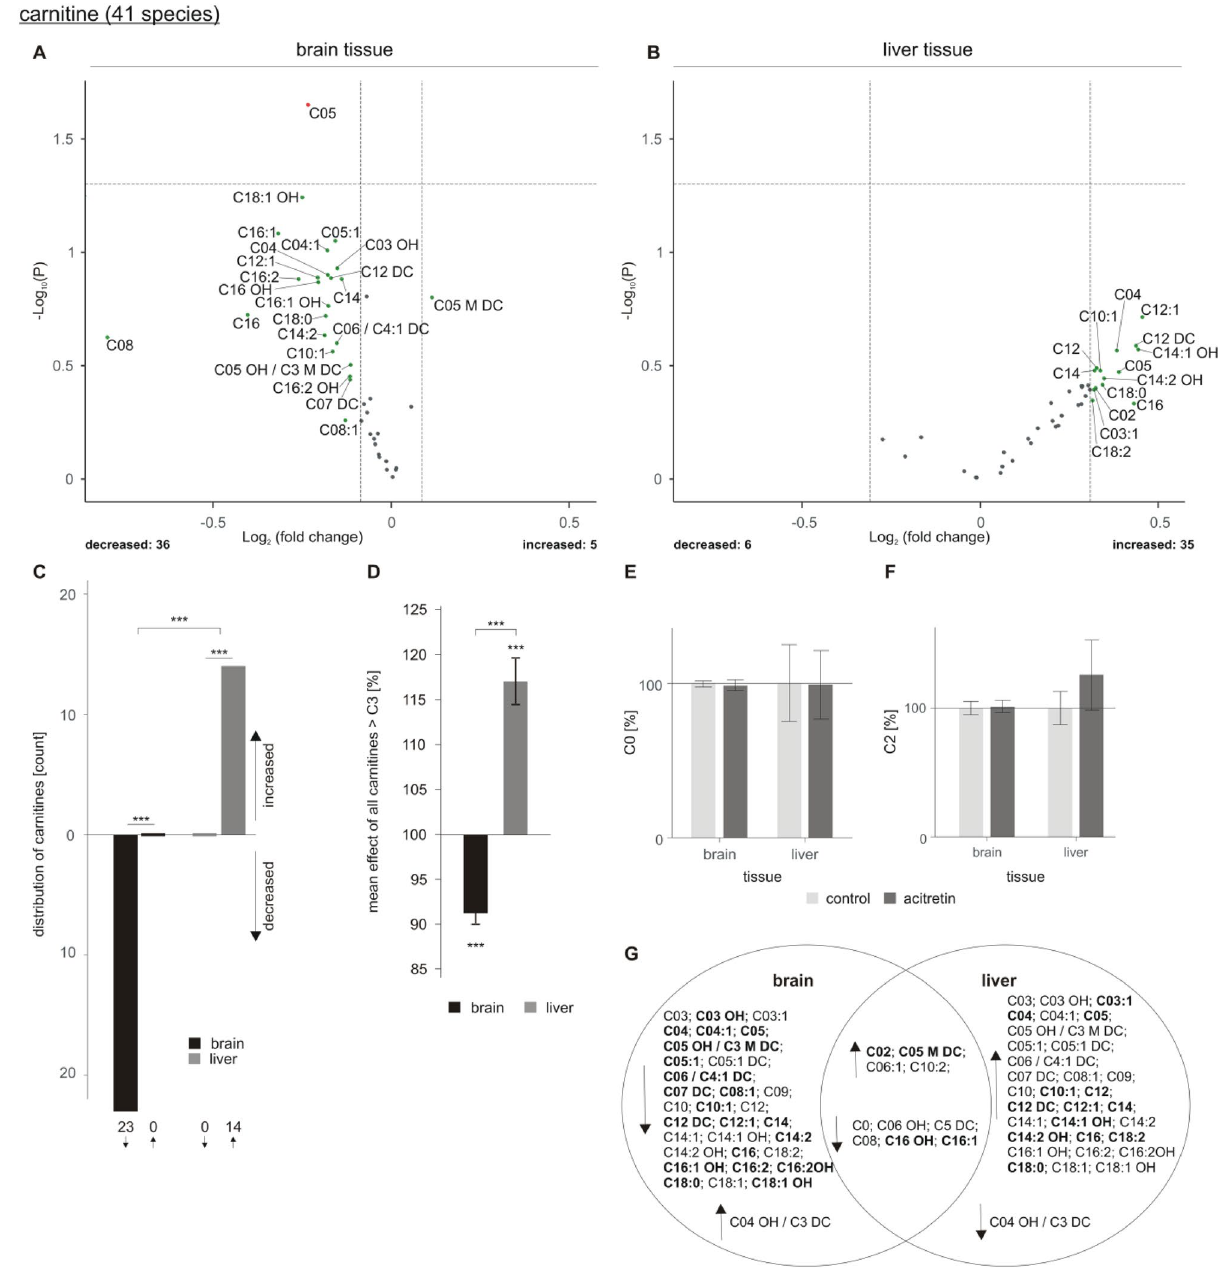
Figure 7. Changed carnitine levels in 5xFAD brain and liver tissue after acitretin treatment. Fold changes of single carnitine species in brain and liver tissue are shown as volcano plots at the top ( A : brain tissue, B : liver tissue). Structure and labeling of the volcano plots are according to Fig. 2. ( C ) Distribution of carnitine species represented as number of de- and increased parameters in brain and liver tissue in a bar chart. ( D ) Mean effects on all carnitines in brain and liver tissue are shown in a bar chart. Statistical significance for ( C ) and ( D ) was calculated according to Fig. 3. Fold changes of carnitines CO ( E ) and C2 ( F ) in brain or liver tissue after acitretin treatment are represented as bar chart. Statistical significance was calculated using two sample t-test. ( G ) Venn diagram showing exclusively changed as well as overlapping carnitine species in brain and liver tissue. Species with a fold change greater than the SEM are highlighted in